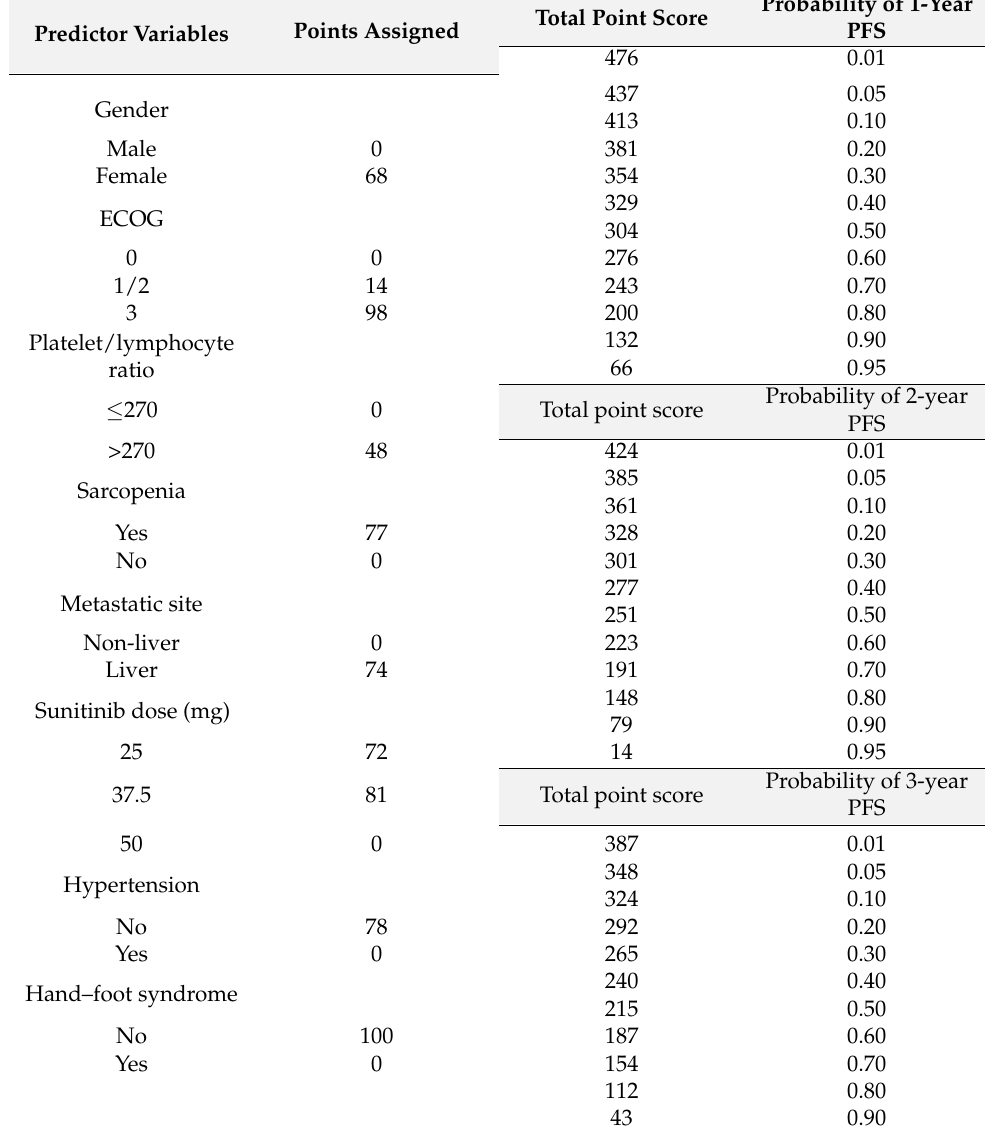
Table 4. Point assignment for each variable and prognostic score for progression-free survival. Predictor